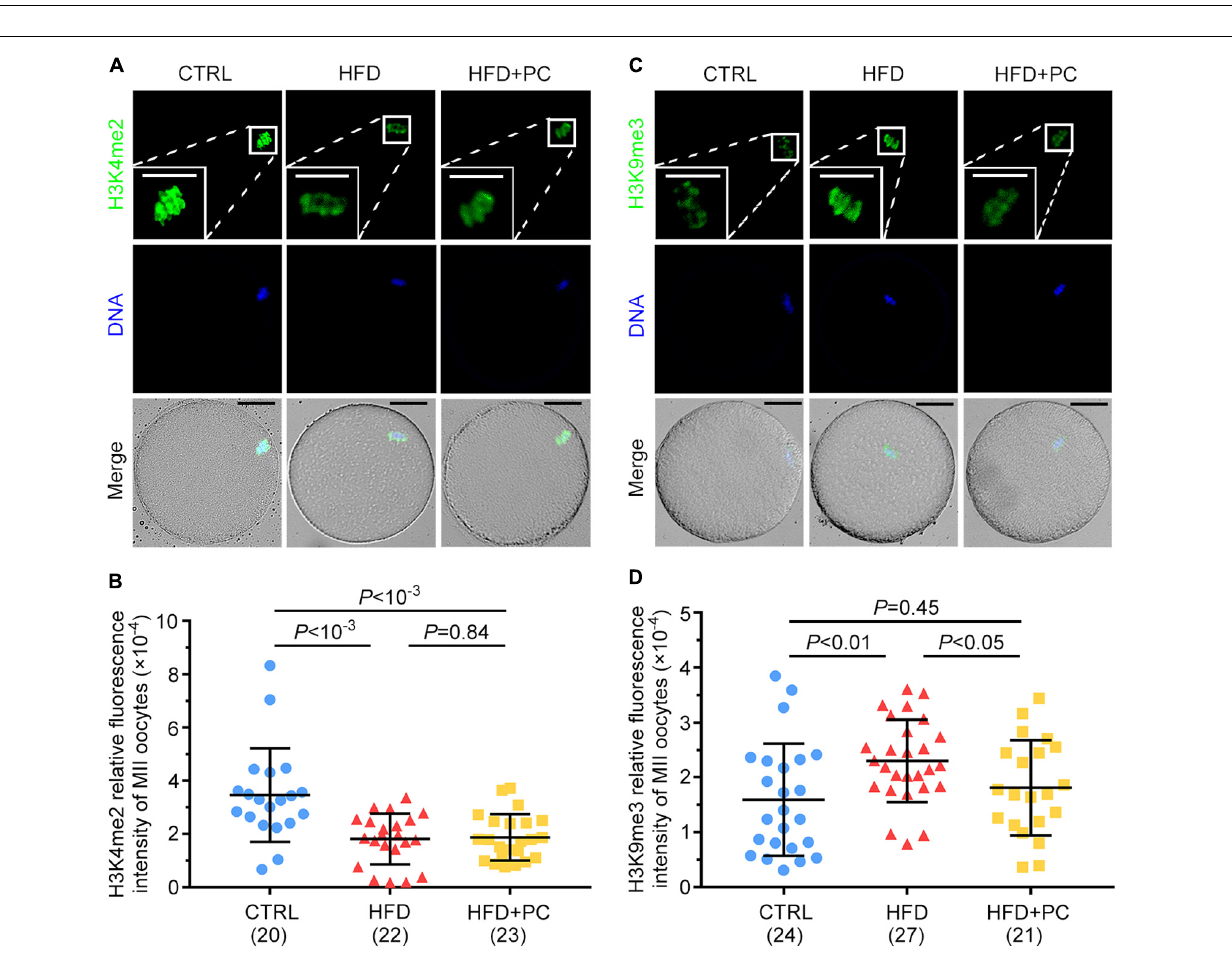
FIGURE 7 | PC reversed the abnormal expression of H3K9me3 in obese mice. (A) Representative images of H3K4me2 inside oocytes. Green, H3K4me2; blue, DNA. The square white frame indicates the region shown in detail. Scale bar = 20 µ m. (B) Quantified fluorescence intensities for H3K4me2. (C) Representative images of H3K9me3 inside oocytes. Green, H3K9me3; blue, DNA. The square white frame indicates the region shown in detail. Scale bar = 20 µ m. (D) Quantified fluorescence intensities for H3K9me3. Data are expressed as mean ± SD and were compared by one-way ANOVA and Newman–Keuls post hoc tests. The number of oocytes assessed in each group is shown in